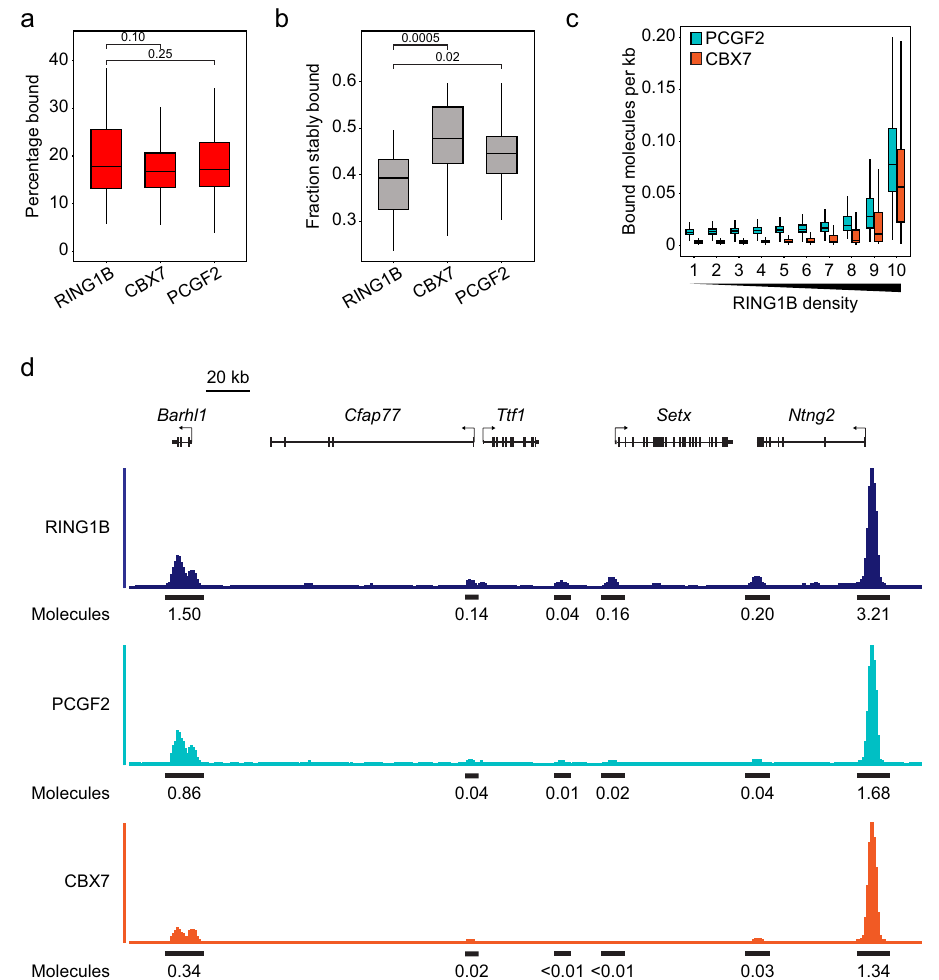
Fig. 6 Canonical PRC1 exhibits stable chromatin binding and is restricted to a subset of Polycomb sites. a A box plot of the percentage of RING1B, CBX7 and PCGF2 molecules in the bound state as determined by SPT. Box plots represent measurements from n > 50 movies from 3 experiments each. Indicated p -values were calculated using a two-tailed Student ’ s t test. Source data are provided as a Source Data fi le. b A box plot indicating the fraction of RING1B, CBX7 and PCGF2 molecules exhibiting stable binding. Box plots represent measurements from n > 15 movies from at least 2 experiments. Indicated p - values were calculated using a two-tailed Student ’ s t test. Source data are provided as a Source Data fi le. c A box plot illustrating the number of PCGF2 (turquoise) and CBX7 (orange) molecules that are estimated to be bound per kilobase of DNA at RING1B peaks from ChIP-seq in ESCs 49,79 . Read distributions aggregated from n = 3 biological replicates of PCGF2 and CBX7 ChIP-seq were used to segregate bound PCGF2 and CBX7 molecules into density deciles over RING1B peaks. Source data are provided as a Source Data fi le. d A genomic snapshot illustrating RING1B, PCGF2 and CBX7 ChIP-seq signal at two strong PRC1 peaks sites and four weaker peaks illustrating the more restricted nature of PCGF2 and CBX7 binding. Values shown below the ChIP-seq signal indicate the estimated number RING1B, PCGF2 and CBX7 molecules bound at a single allele for the indicated peak. In a – c , boxes represent the interquartile range (IQR), the middle line corresponds to the median, and whiskers extend to the largest and smallest values no more than 1.5 x IQR from the box. Values outside of this range are not plotted, but are included in all